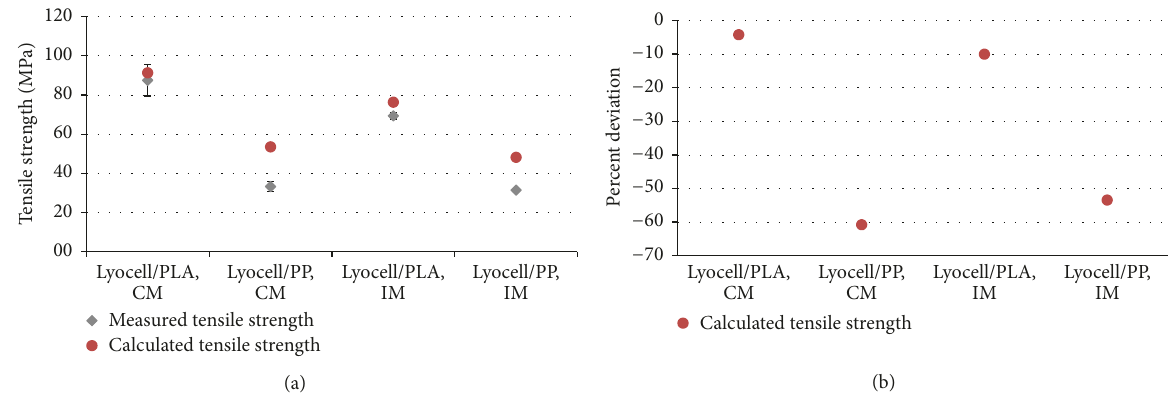
Figure 8: Measured tensile strength (mean value standard deviation) of CM and IM lyocell/PLA and lyocell/PP composites compared to calculated strength values according to Kelly and Tyson (a) and percent deviation between measured values and calculated values (b).